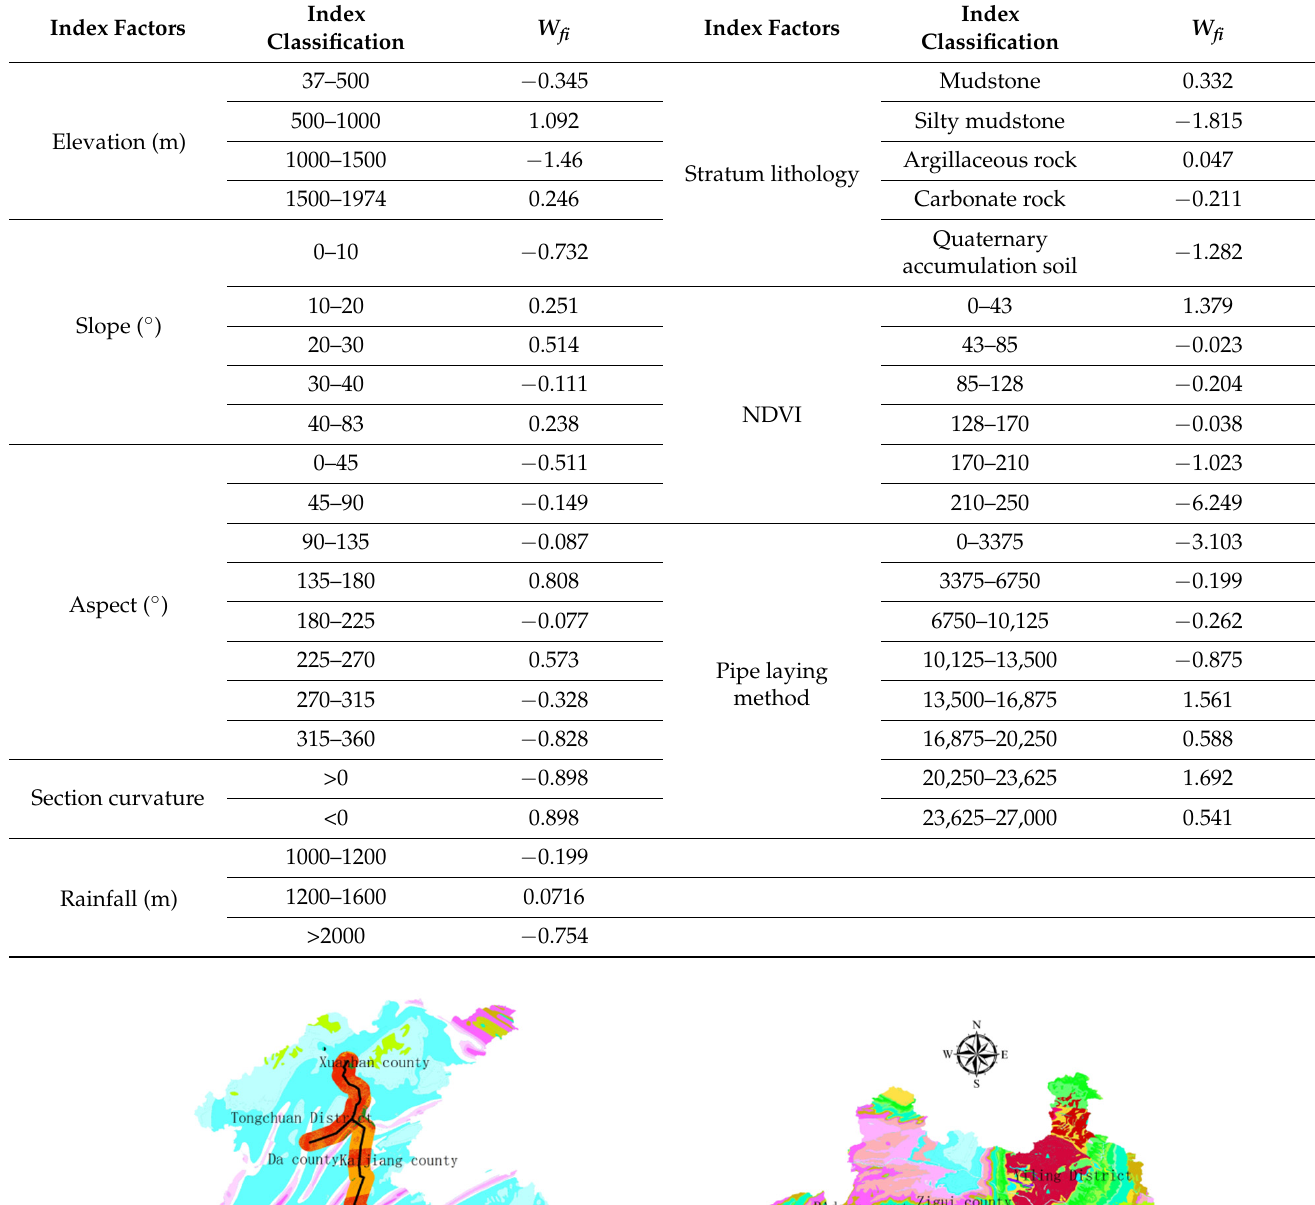
Table 1. Index factors and W fi .